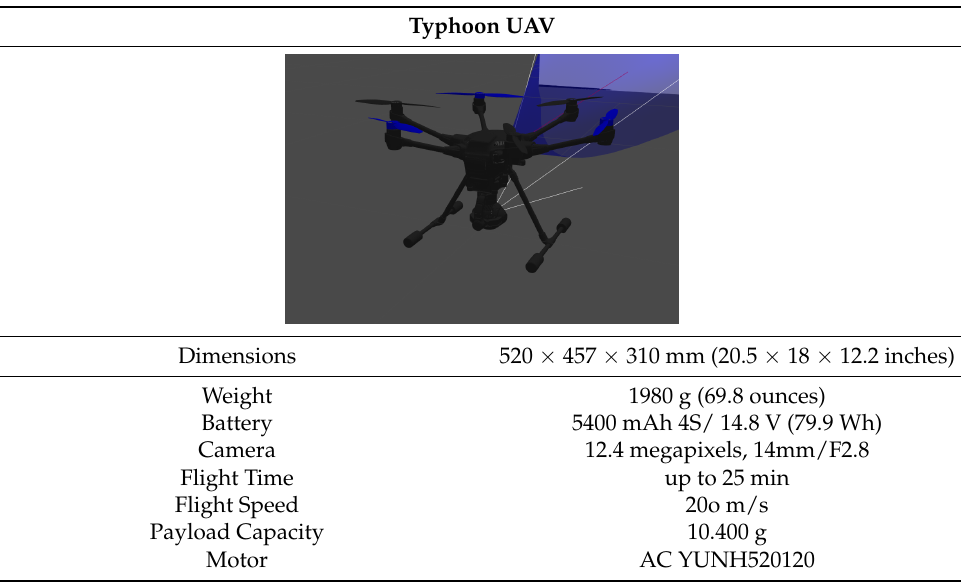
Table A1. Yuneec Typhoon UAV technical